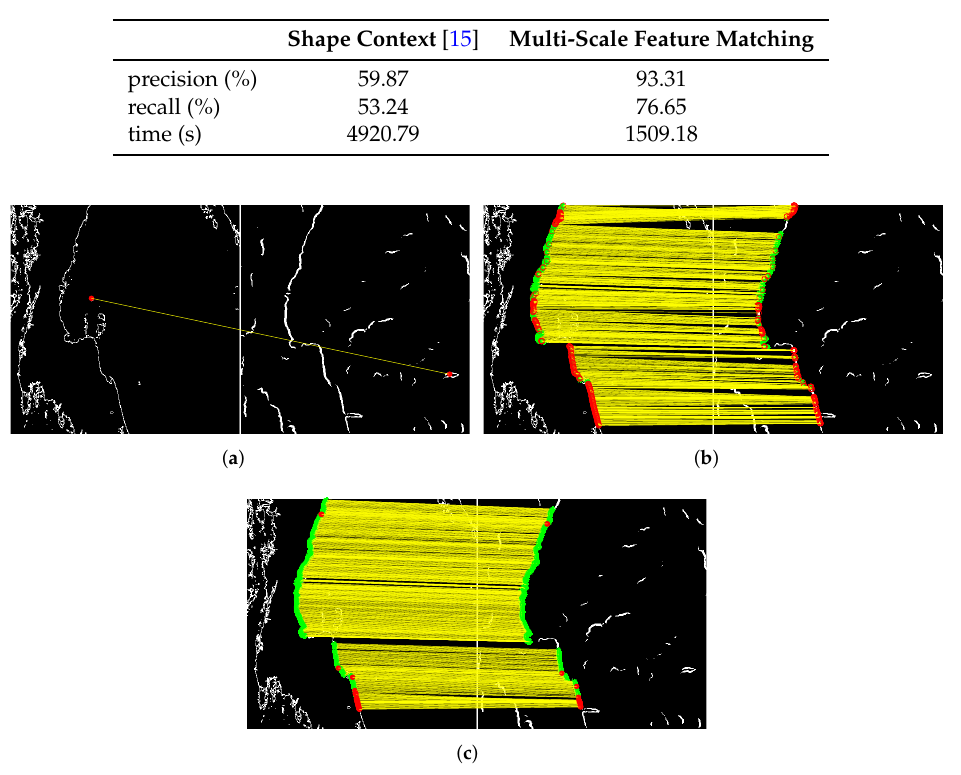
Table 1. Corresponding values of average precision, recall and computation time obtained by shape context and multi-scale feature matching.